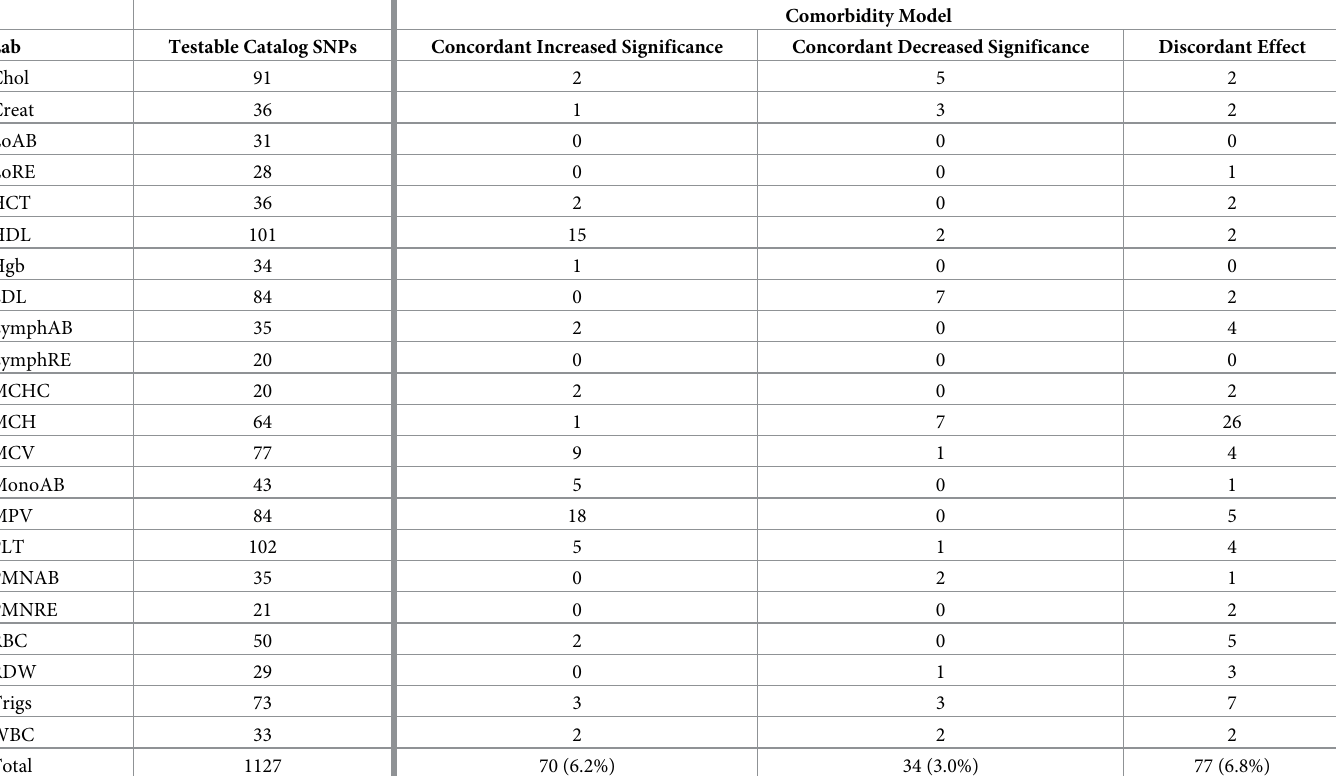
Table 4. Classification of catalog SNPs for the comorbidity model, which includes covariates for various lab-altering